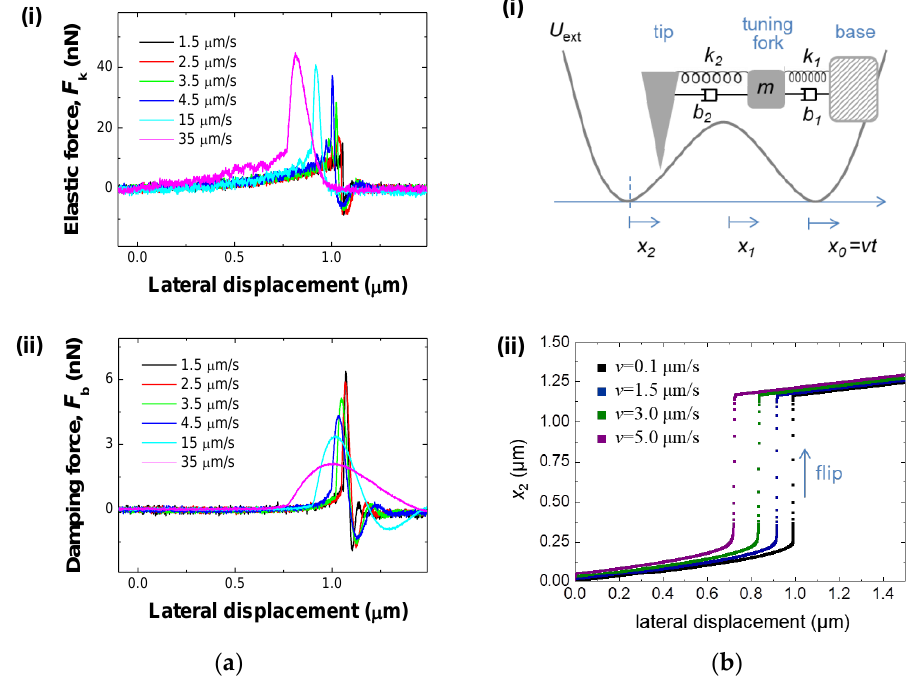
Figure 3. Speed dependence of mechanical responses by the buckling cantilever: ( a ) the mechanical sensor detects the elastic forces ( F k -(i)) as well as the viscous forces ( F b -(ii)) while the buckling cantilever experiences abrupt flipping during lateral movement of the tip with the tip speed of 1.5 µ m/s~35 µ m/s. The buckling cantilever starts to sense the interaction away from the flipping point as the speed of the tip movement increases; ( b ) non-linear transition model. (i) The coupled cantilever–oscillator model, where the tip is present in double-well potential U ext and connected with the tuning fork and the tuning fork base moves at a constant velocity v . (ii) Non-linear transient dynamics of the tip for different normalized velocities of the base: v = 0.1, 1.5, 3, and 5 μm/s . With increasing v , the flipping point decreases at which the static bifurcation occurs, which is consistent with experimental results.